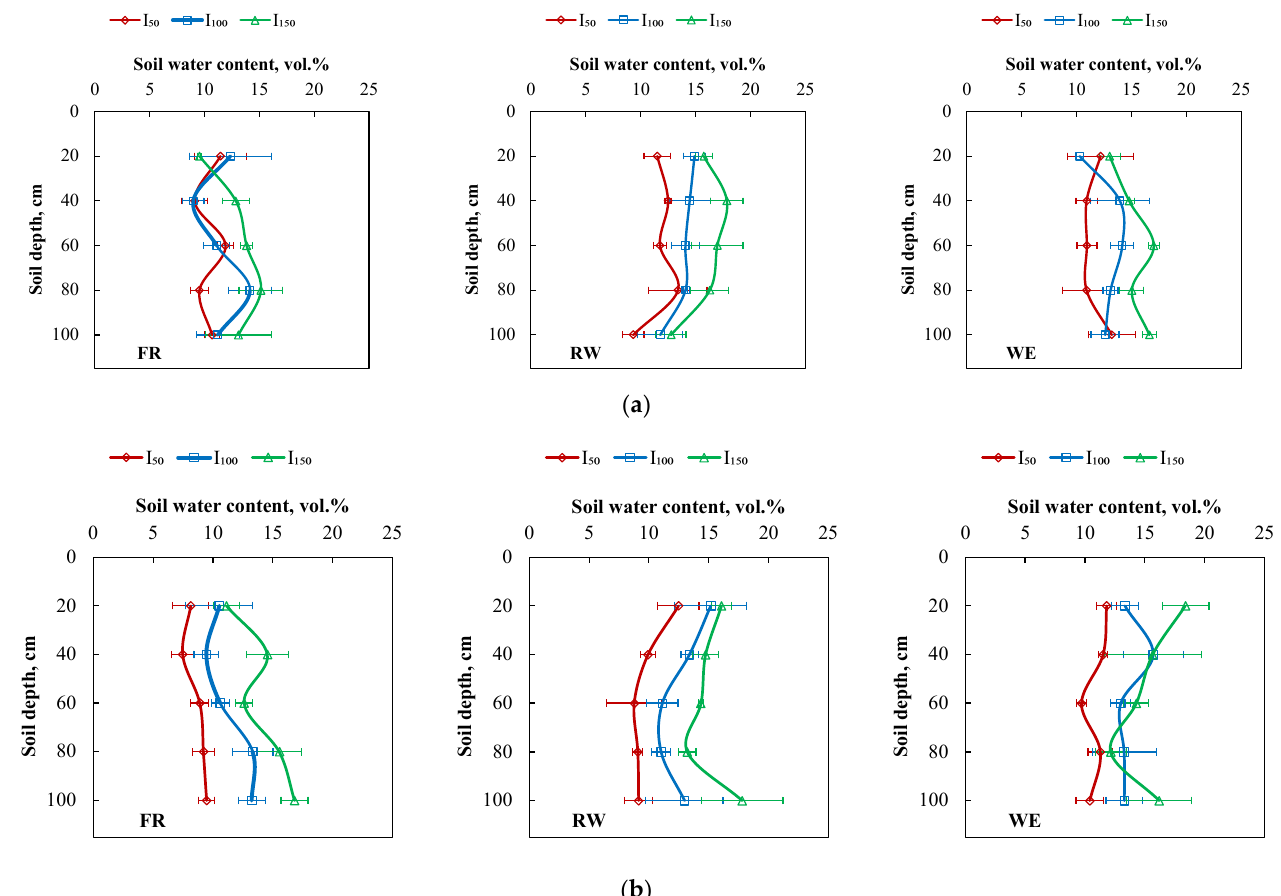
Figure 2. Volumetric soil water content distribution in the three irrigation levels (I 50 , I 100 , and I 150 : 50%, 100%, and 150% crop evapotranspiration, respectively) across three water qualities (FR: freshwater, RW: reclaimed wastewater, and WE: well water) measured at three dates in ( a ) 2017 and ( b ) 2018. Bars represent mean values ± standard error of triplicate measurements.